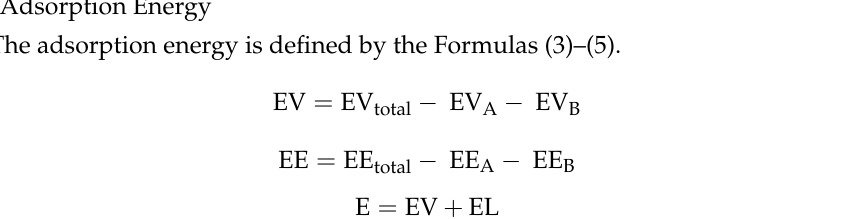
Figure 7. Mass density of different systems ( a ) STAC; ( b ) SDBS.